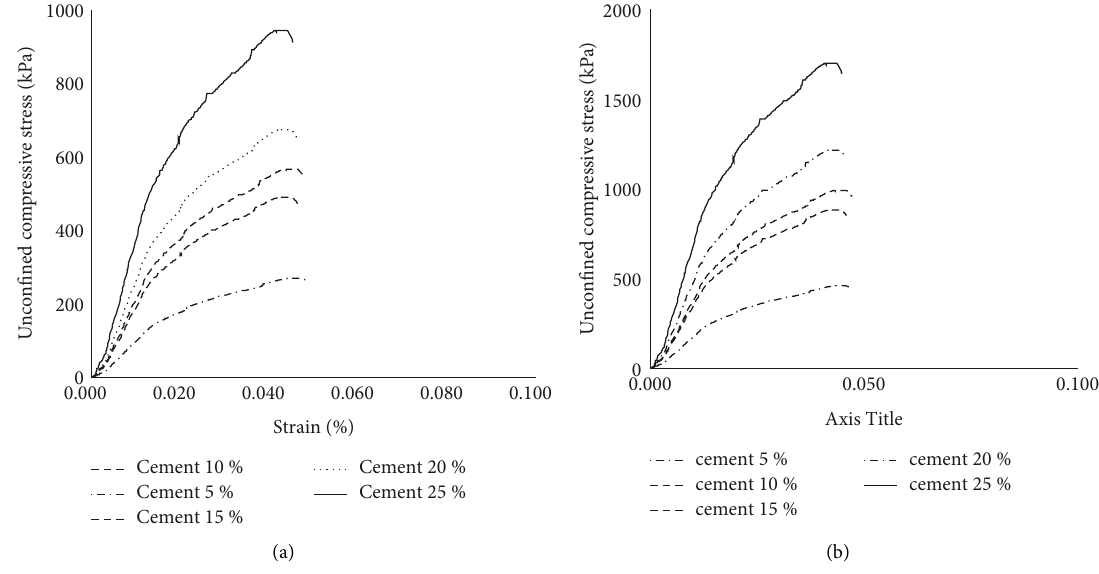
Figure 8: Results of the uniaxial pressure test in different percentages of cement. (a) 7-day curing and (b) 28-day curing.